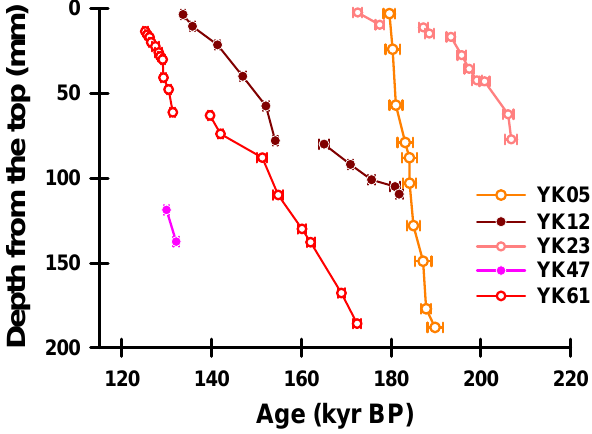
Figure 3. Age models of Yangkou stalagmites, established with U- Th dates with 2 σ precisions of ± 0 . 3 − 1 . 0% (horizontal error bars).